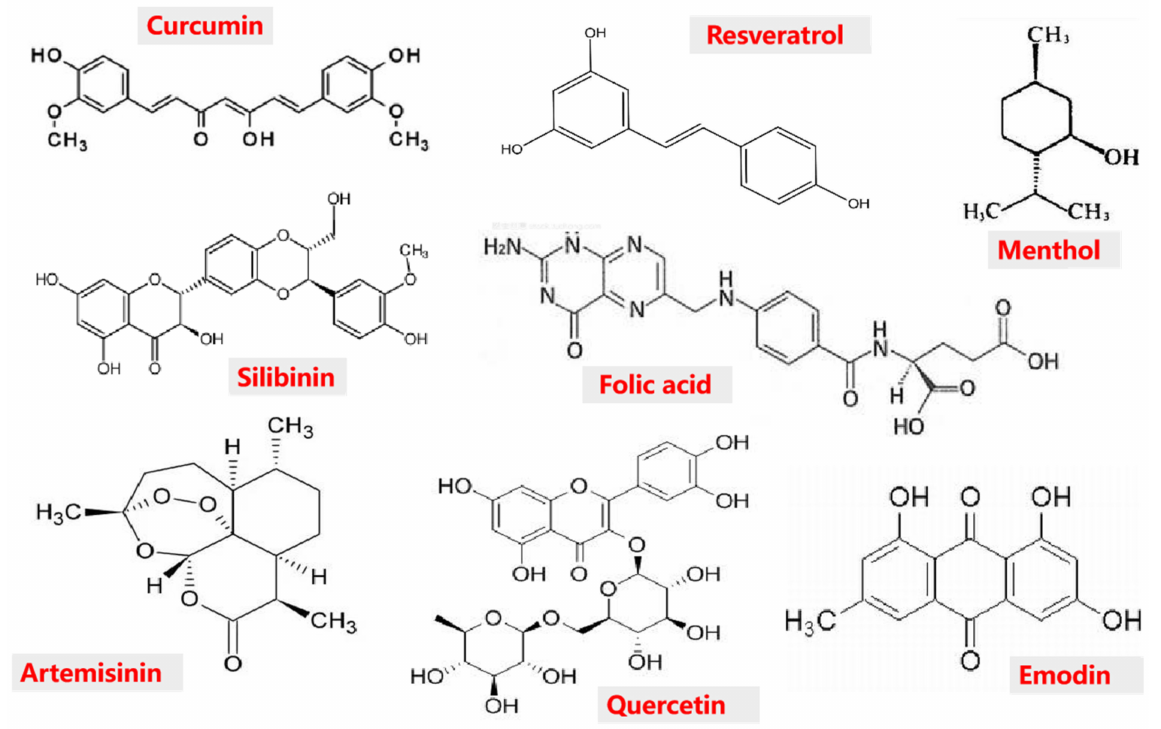
Figure 1. Molecular structure of some common bioactive